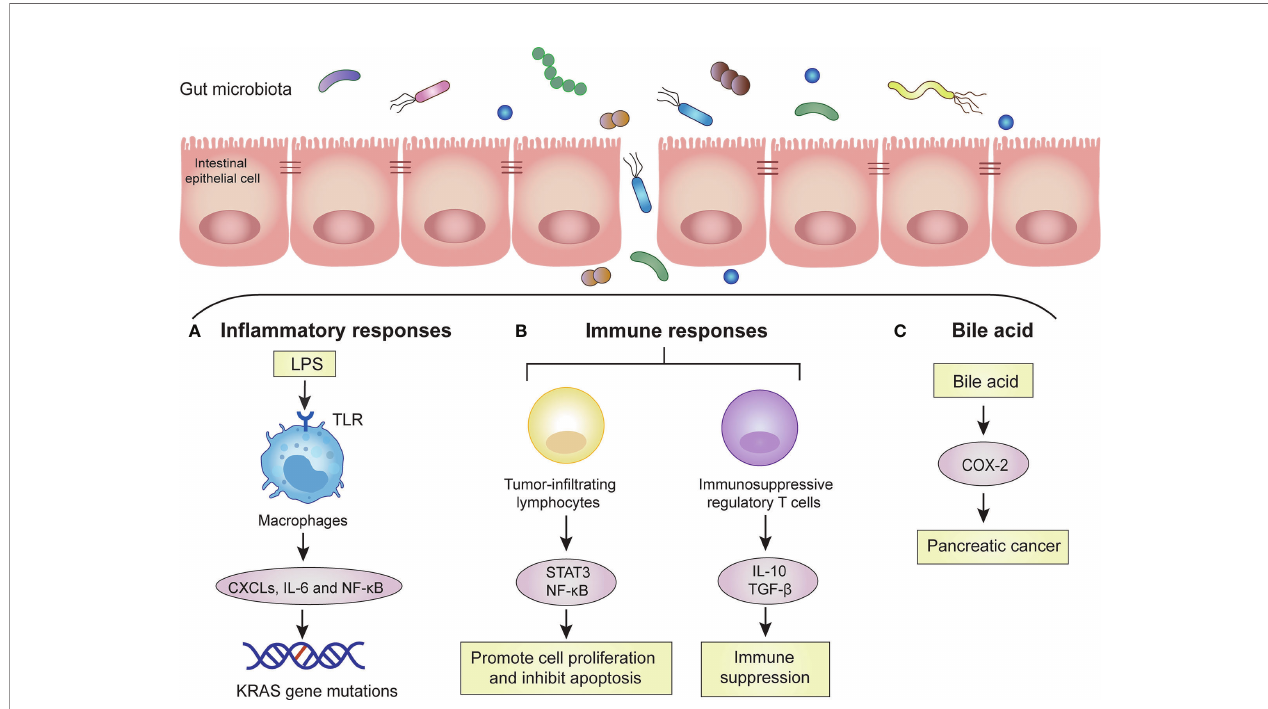
FIGURE 1 | Mechanisms of the gut microbiota in PC. The gut microbiota promotes the carcinogenesis of PC cells by these mechanisms, such as in fl ammatory response, immune response and bile acid. Dysbiosis of gut microbiota increases bacterial invasion, which promotes carcinogenesis of pancreatic cells. (A) In fl ammatory responses: Invasive bacteria enter the bloodstream and release large amounts of LPS. LPS is recognized by TLRs on macrophages. Macrophages are activated to release some proin fl ammatory cytokines (CXCLs, IL-6) and activate signaling pathways (NF-kB). Accumulated in fl ammatory responses induce KRAS gene mutation. (B) Immune responses: Invasive bacteria activate tumor-in fi ltrating lymphocytes and immunosuppressive regulatory T cells. Tumor-in fi ltrating lymphocytes can promote cell proliferation and inhibit apoptosis through the STAT3 and NF- k B signaling pathways. Immunosuppressive regulatory T cells lead to systemic immune suppression by releasing IL-10 and transforming growth factor- b (TGF- b ). (C) Bile acid: bile acid can upregulate the mRNA of cyclooxygenase-2 (COX-2) in PC cells to increase the invasion ability of tumor